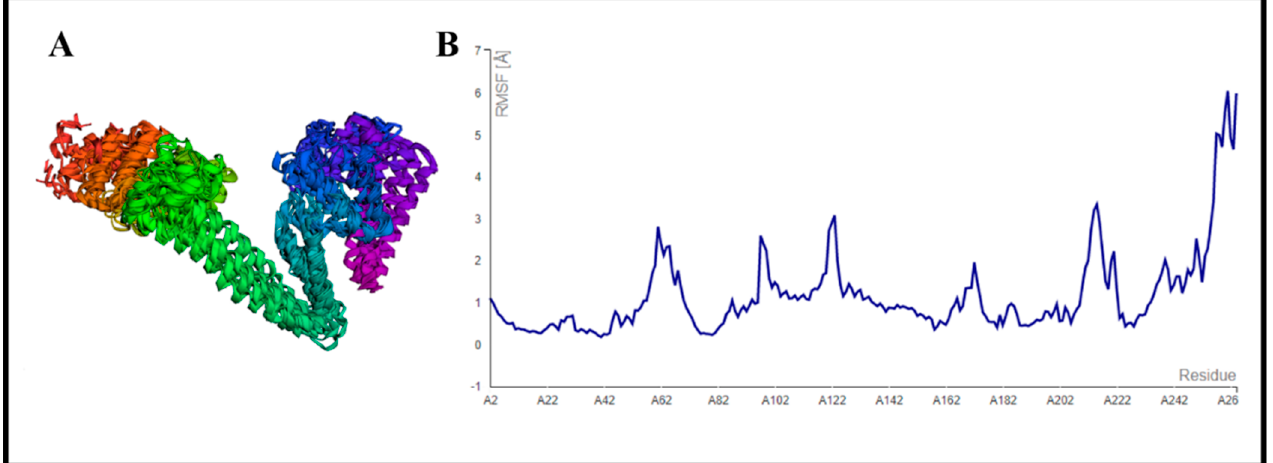
Figure 6. Structural flexibility analysis of the refined MEV construct: ( A ) 10 superimposed models generated by CABS − flex 2.0 server [44]; ( B ) root mean square fluctuation (RMSF) results of designed MEV construct.